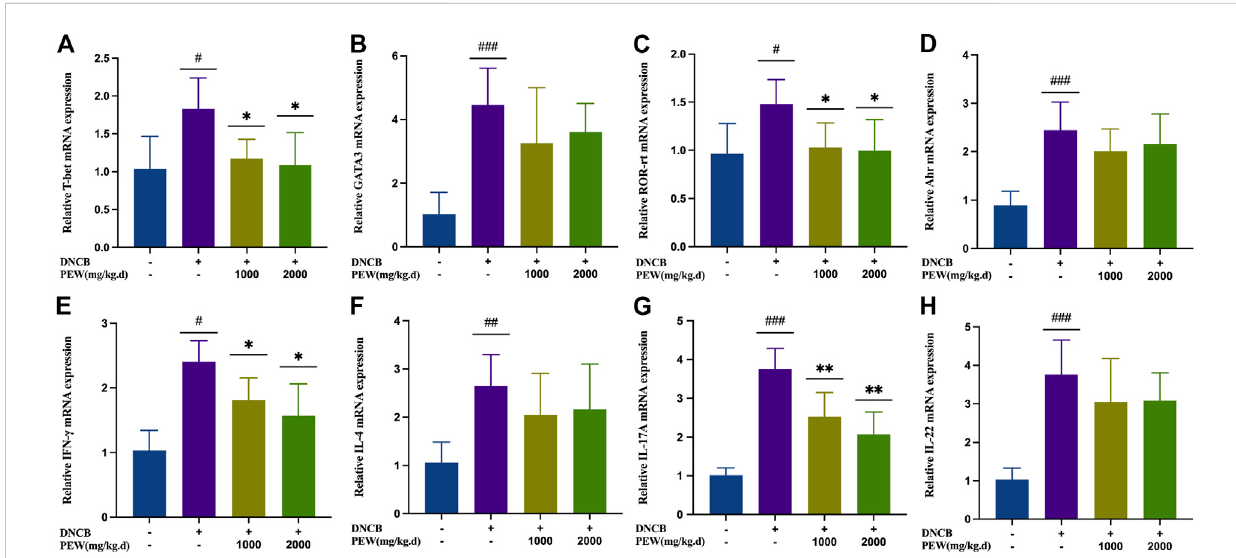
FIGURE 6 PEW reduces mRNA expression of Th1 and Th17 cytokines and nuclear transcript factors (IFN- γ , T-bet, IL-17, and ROR-rt) in DNCB-induced mice skin lesions. (A – H) . Relative mRNA expression levels of different nuclear transcript factors and cytokines ( n = 5/group): (A) T-bet, (B) GATA-3, (C) ROR-rt, (D) AHR, (E) IFN- γ , (F) IL-4, (G) IL-17A, and (H) IL-22. The data were presented as means ± SD. # p < 0.05, ## p < 0.01, ### p < 0.001 VS. the normal group; * p < 0.05, ** p < 0.01 VS. the model control group.